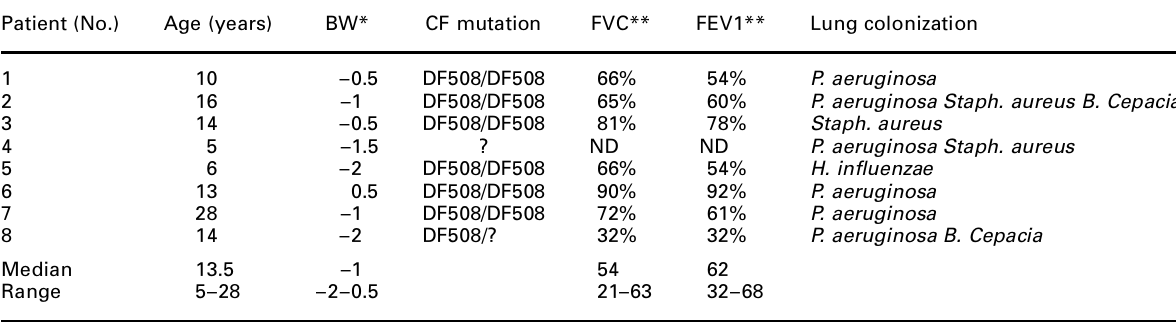
Table 1. Baseline characteristics of patients before colchicine treatment Patient (No.)